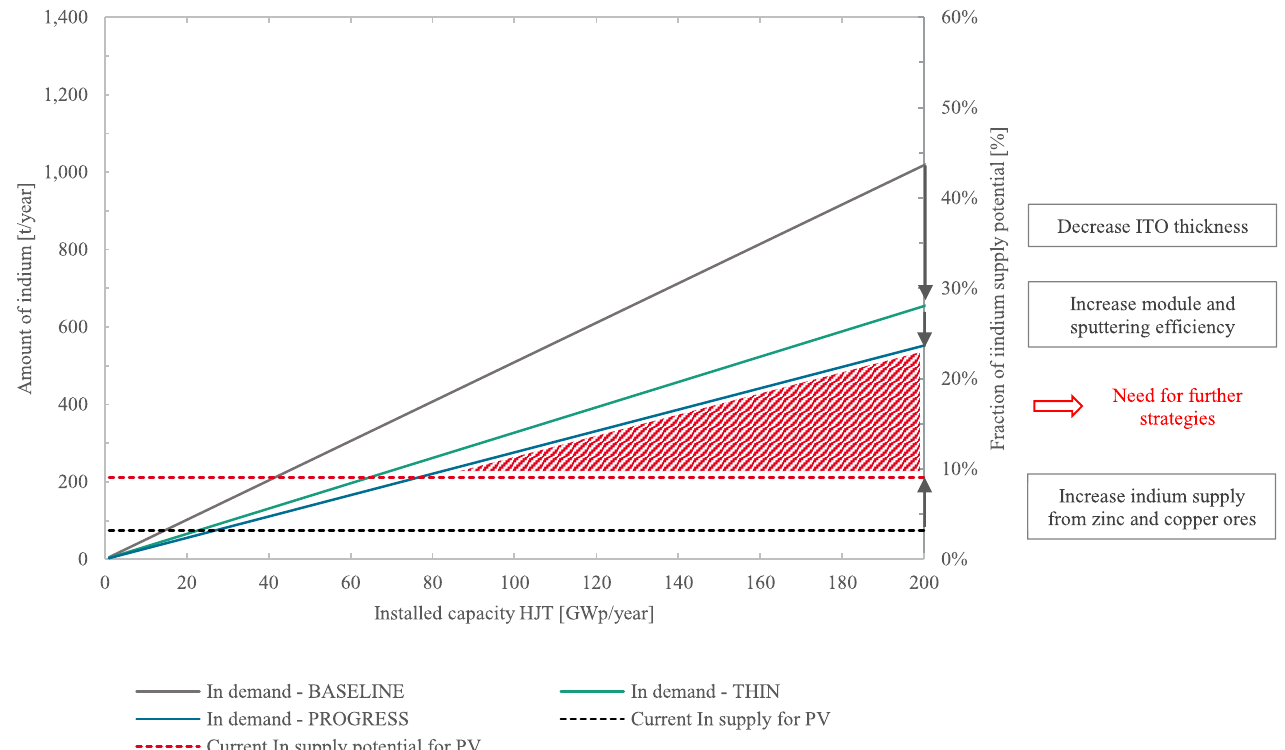
Fig. 2. Comparison of the indium demand for HJT deployment with the current annual indium supply and indium supply potential for